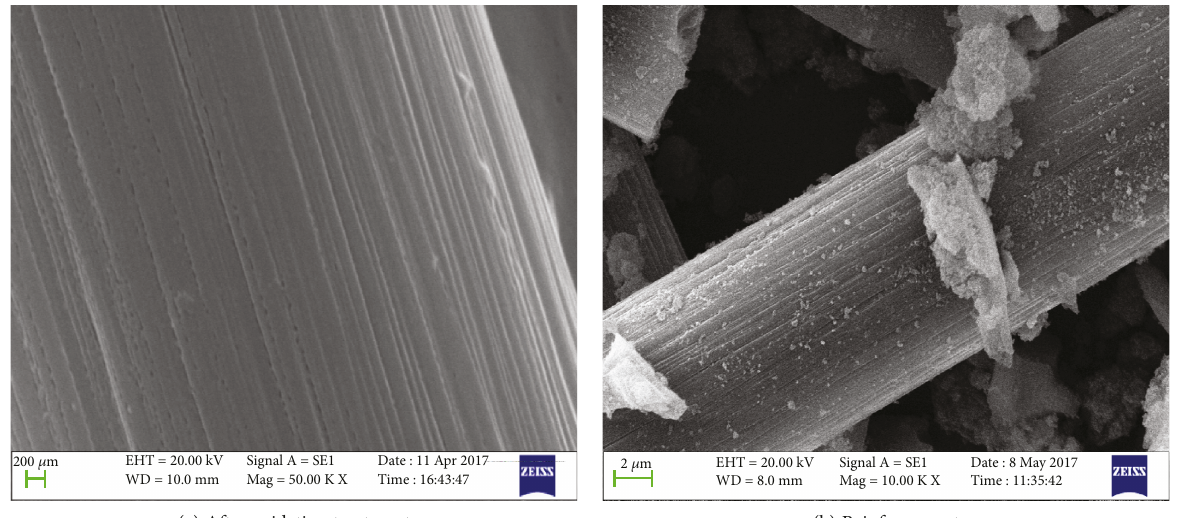
Figure 5: SEM image of the reinforcement and unreinforced carbon fi